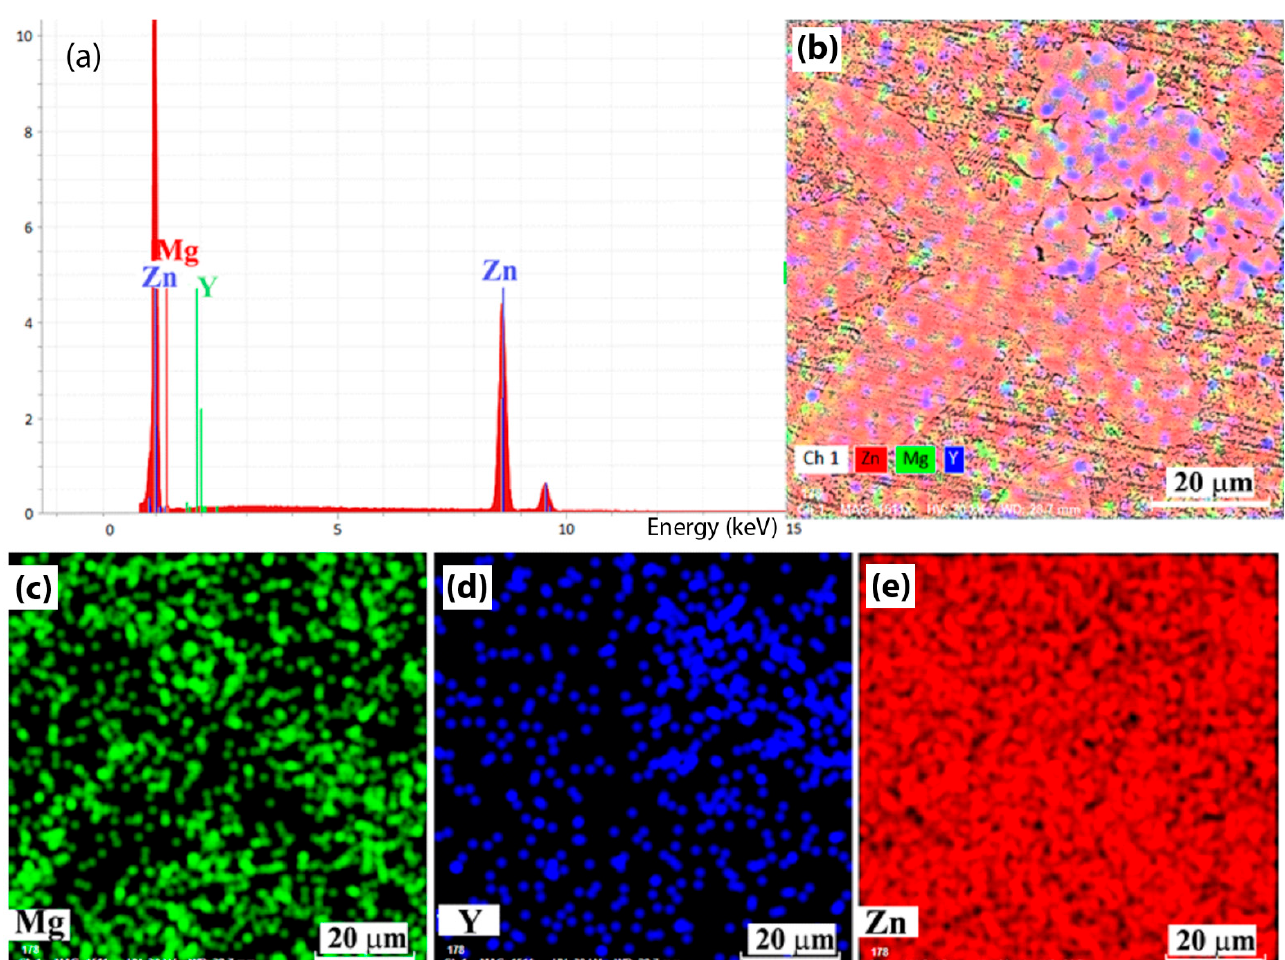
Figure 2. Chemical analysis of experimental alloy ( a ) energy spectrum, ( b ) Zn,MgY elements distribution, ( c ) Mg, ( d ) Y, and ( e ) Zn distributions.